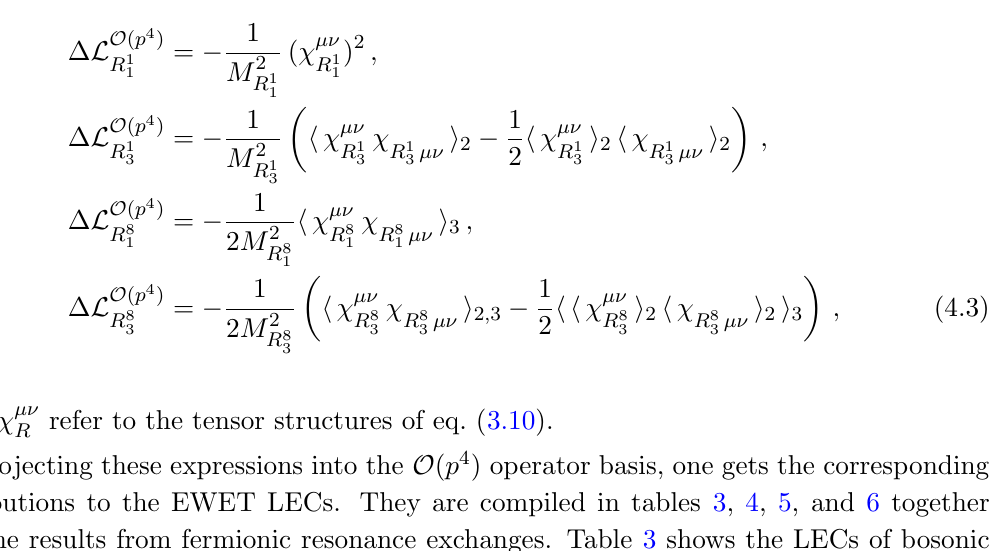
table 6 the LECS of P -odd fermion operators. We have applied several Fierz identities to the spin-0 resonances only contribute to P -even